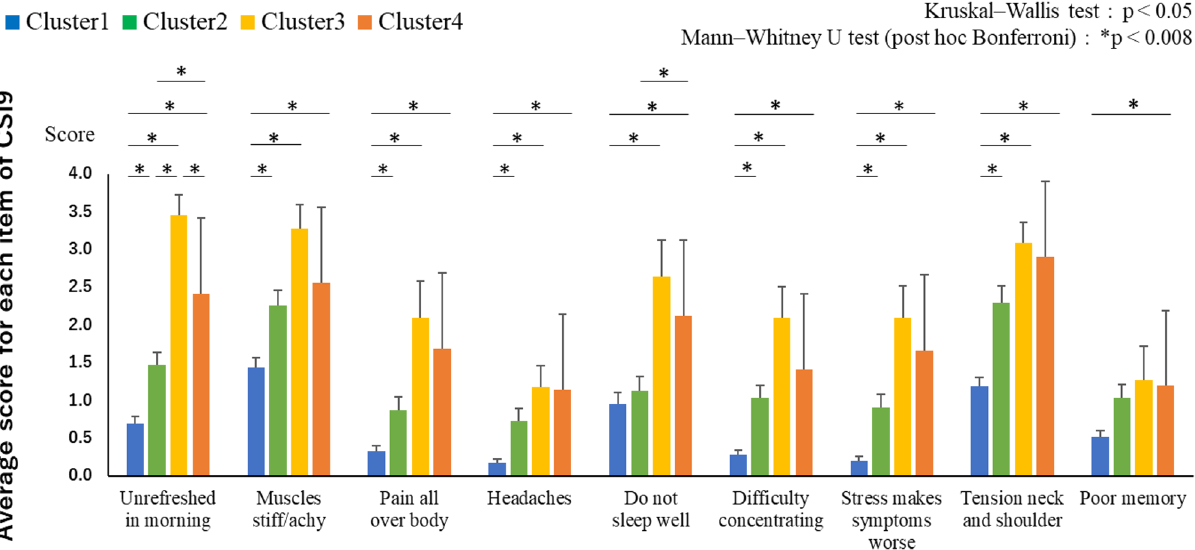
Figure 2. Multiple comparison results for each item of the CSI9. Bars (mean [standard error]) show each item of the central sensitization inventory-9 (CSI9) score for cluster 1 (blue bars), cluster 2 (green bars), cluster 3 (yellow bars), and cluster 4 (orange bars). ( A ) Multiple comparisons between the four subgroups. ( B ) Two groups with high CSI9 and contrasting pain intensity on multiple comparisons (clusters 3 and 4). The figure